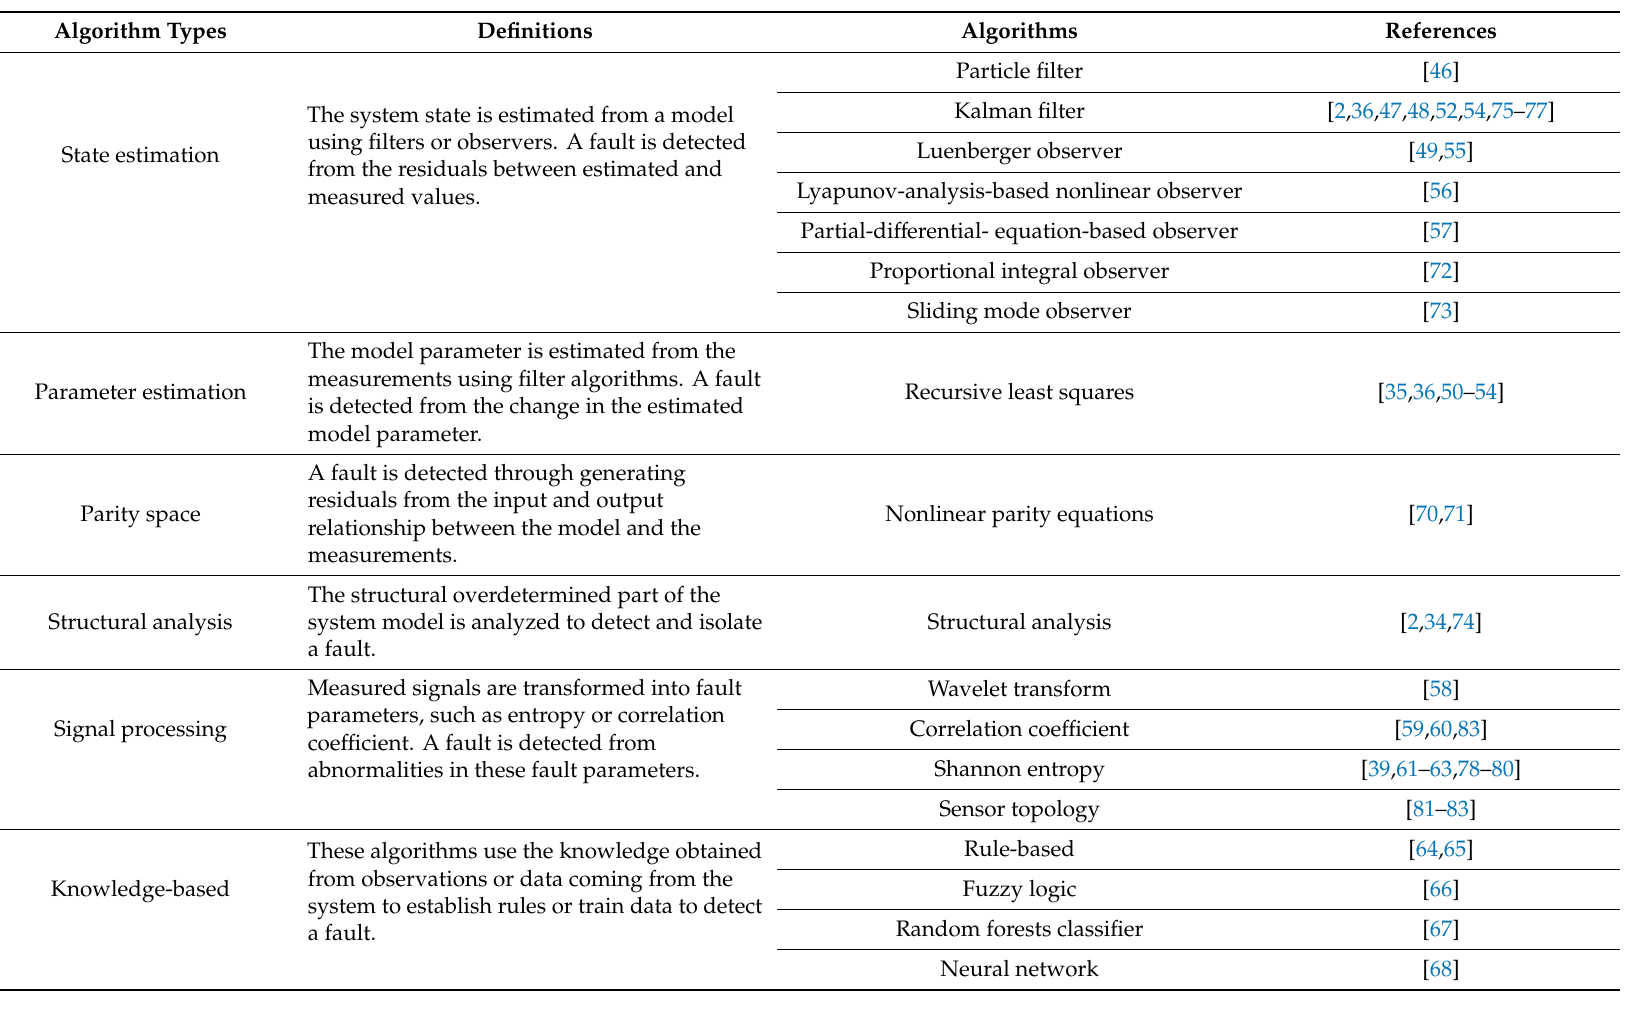
Table 1. Summary of Lithium-ion (Li-ion) fault diagnostic